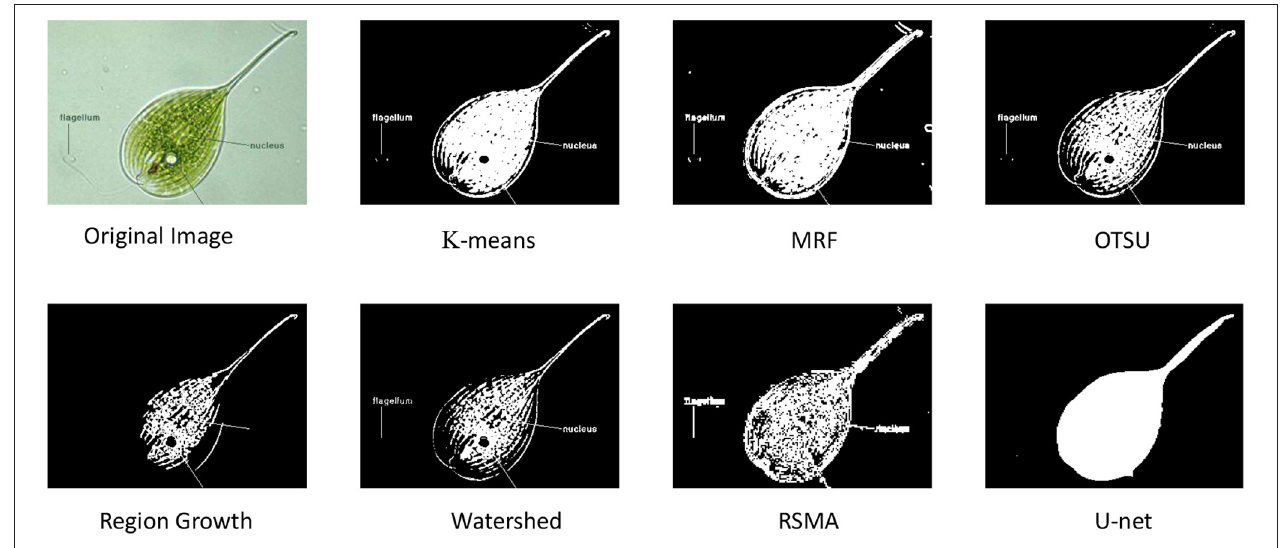
FIGURE 3 | Output of results of different segmentation methods.